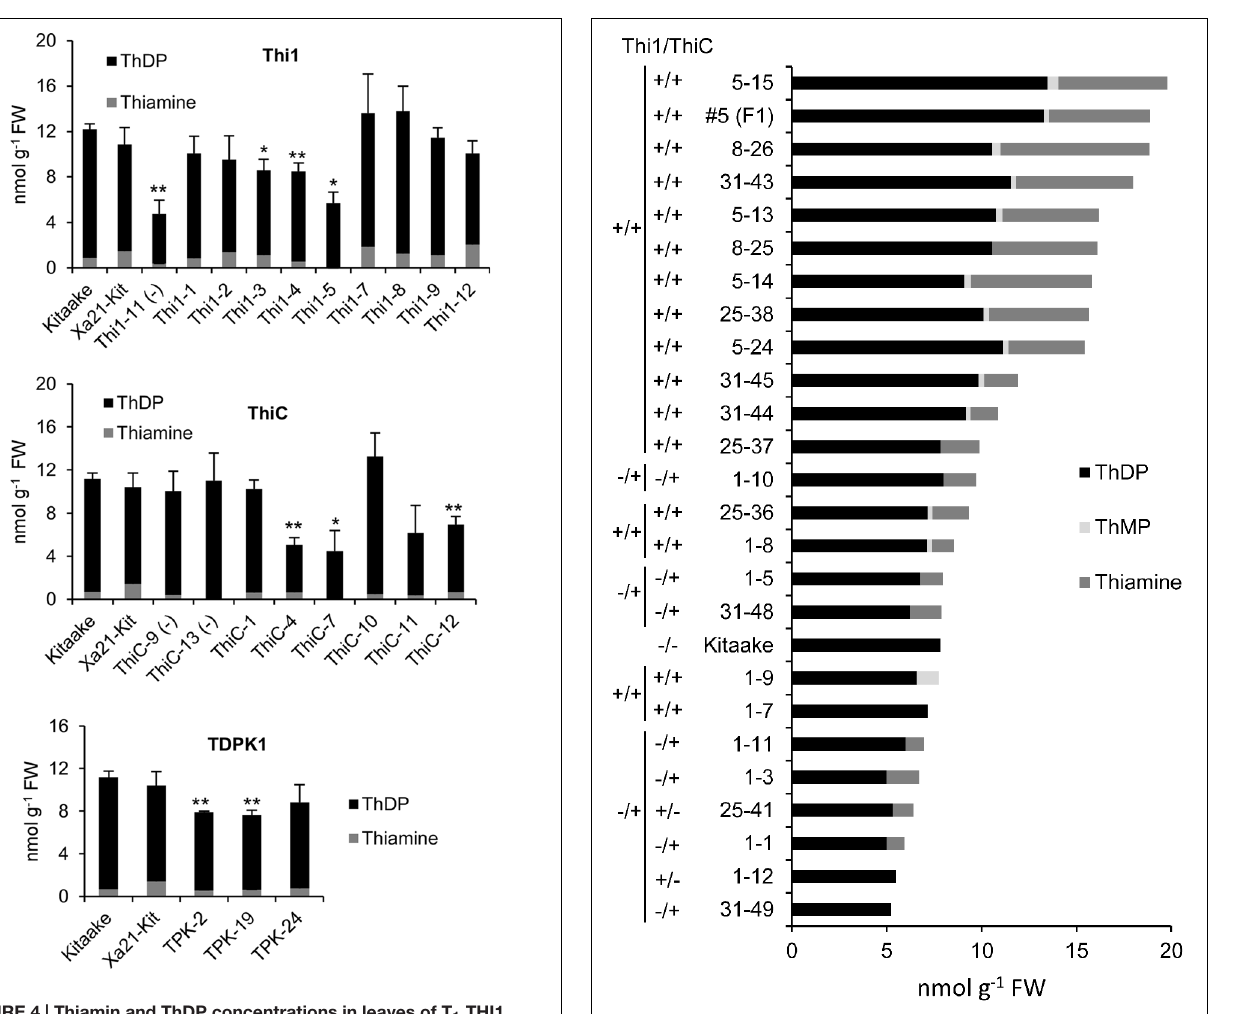
( Figure 6A ). Some seeds (e.g., F 3 seeds from the F 2 5–15